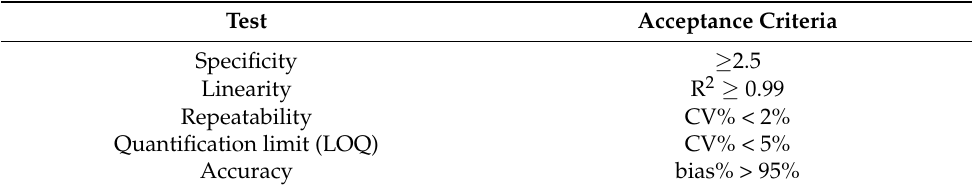
Table 1. Tests and acceptance criteria in determining chemical purity using UV-Radio-HPLC.